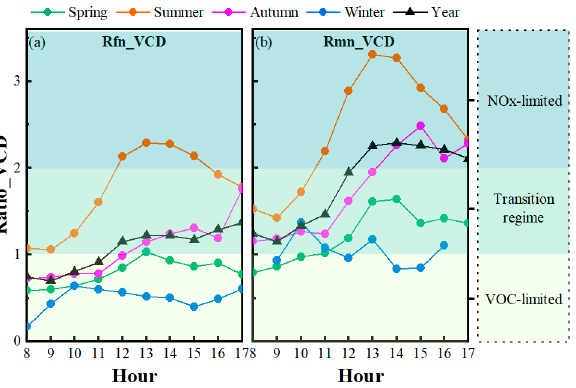
Figure 5. Distribution of ozone formation sensitivity: ( a ) determined by Rfn and ( b ) determined by Rmn